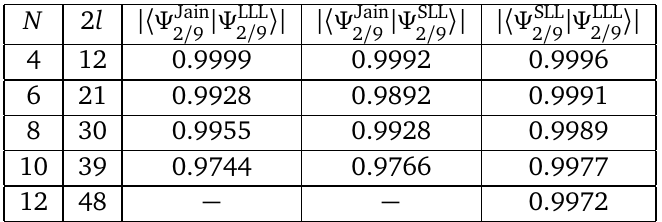
Table 3: Absolute value of the overlap of the exact Coulomb ground state at ν = 2 / 9 〉 and second Landau level (SLL), | Ψ SLL in the lowest Landau level (LLL), | Ψ LLL 2 / 7 〉 obtained in the spherical geometry for N electrons at the 2 / 9 Jain state | Ψ Jain 2 / 9 2 l = 9 N / 2 − 6. For comparison, in the last column, we have shown the overlap between the exact LLL and SLL states. We have not been able to construct the 2 / 9 Jain state for N = 12 electrons, so its overlap with the exact states is currently un- available (indicated by − ). | Ψ LLL N 2 l |〈 Ψ Jain 2 / 9 2 / 9